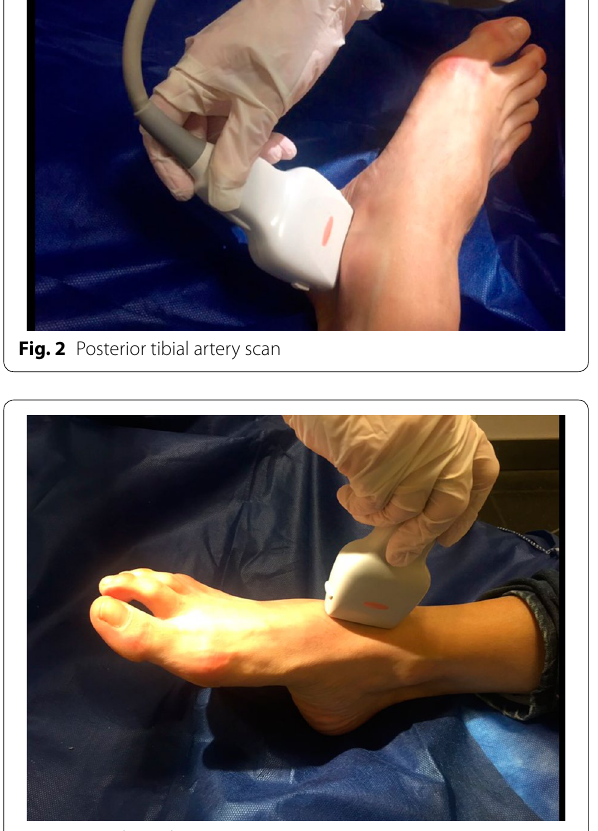
Fig. 3 Dorsalis pedis artery